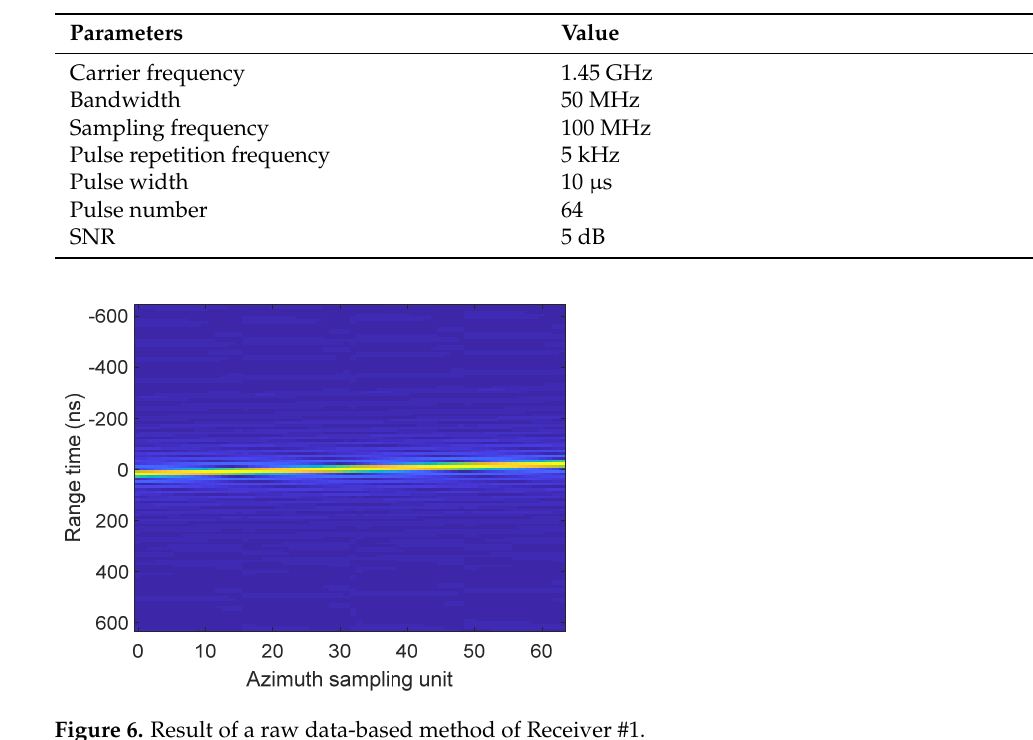
Table 2. Parameters of an LFM signal.